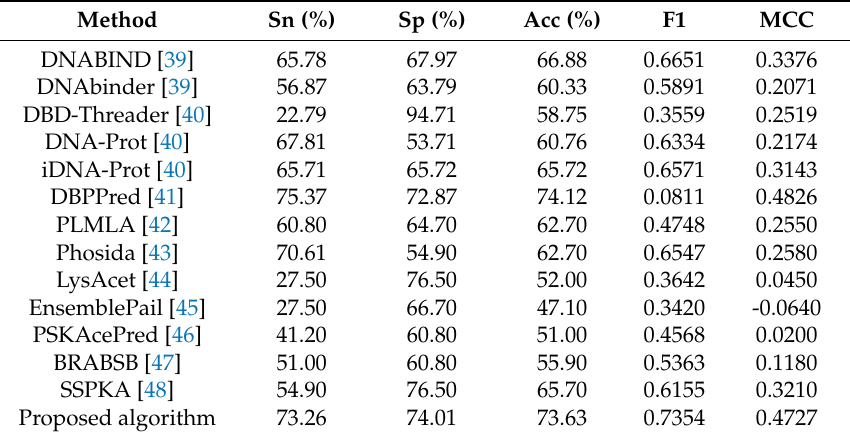
Table 4. Performances of different methods in E. coli .